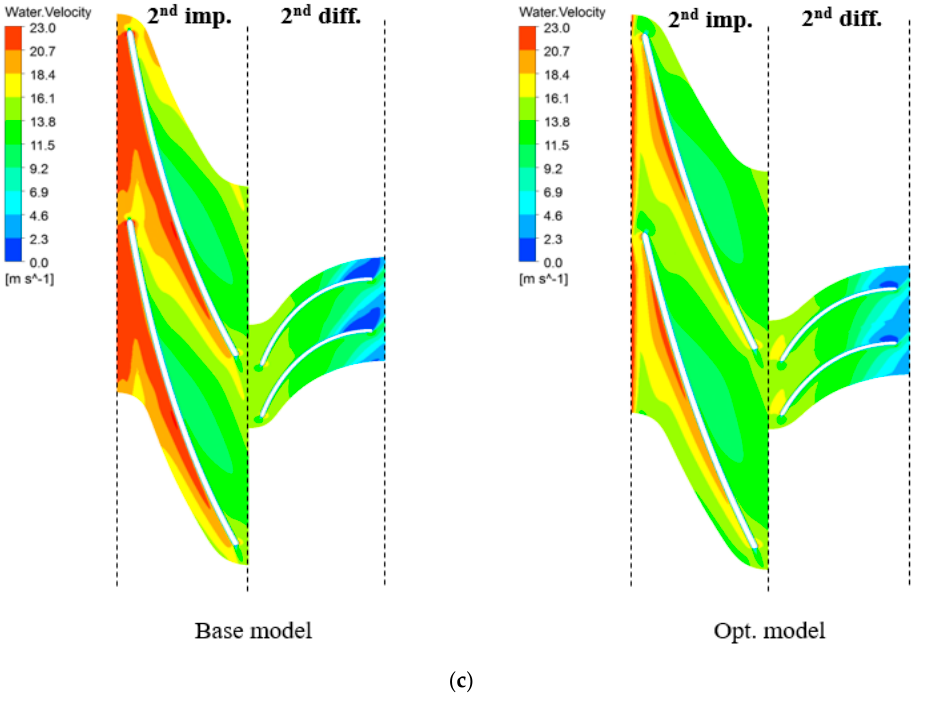
Figure 14. Velocity contour on the blade-to-blade passage. ( a ) At 20% span; ( b ) at 50% span; ( c ) at 80% span.